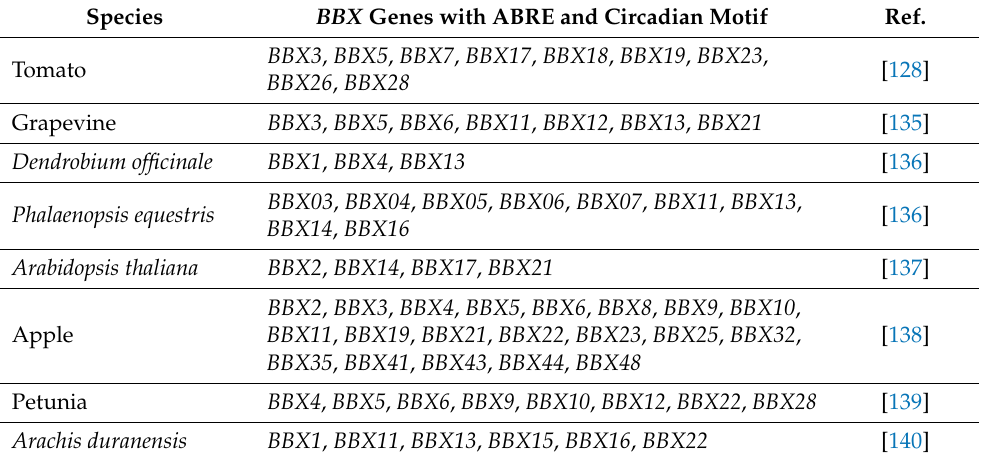
Table 2. List of the BBX genes with both ABRE and circadian “CAANNNATC” motif identified in their